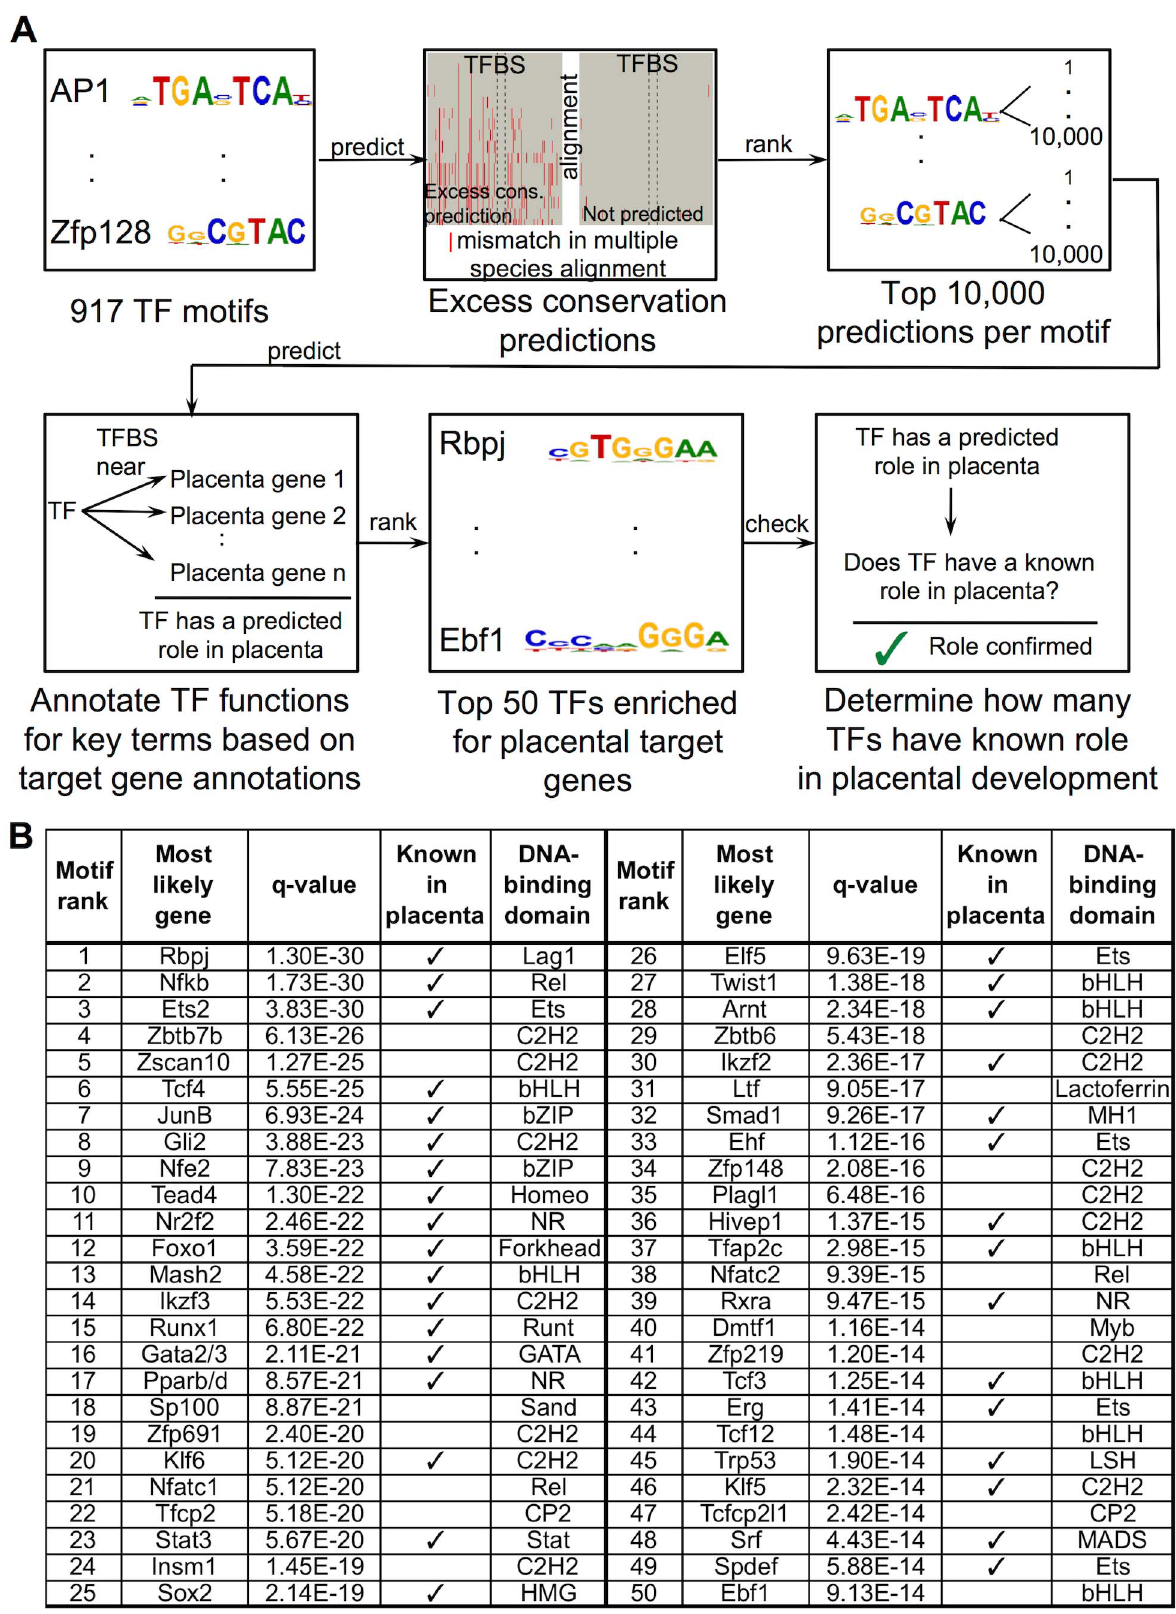
Figure 1. Prediction of transcription factors likely to have a role in placenta development. (A) For a library of 917 motifs, genome-wide binding site predictions were generated using the excess conservation method [7]. The top 10,000 predictions for each motif were analyzed using